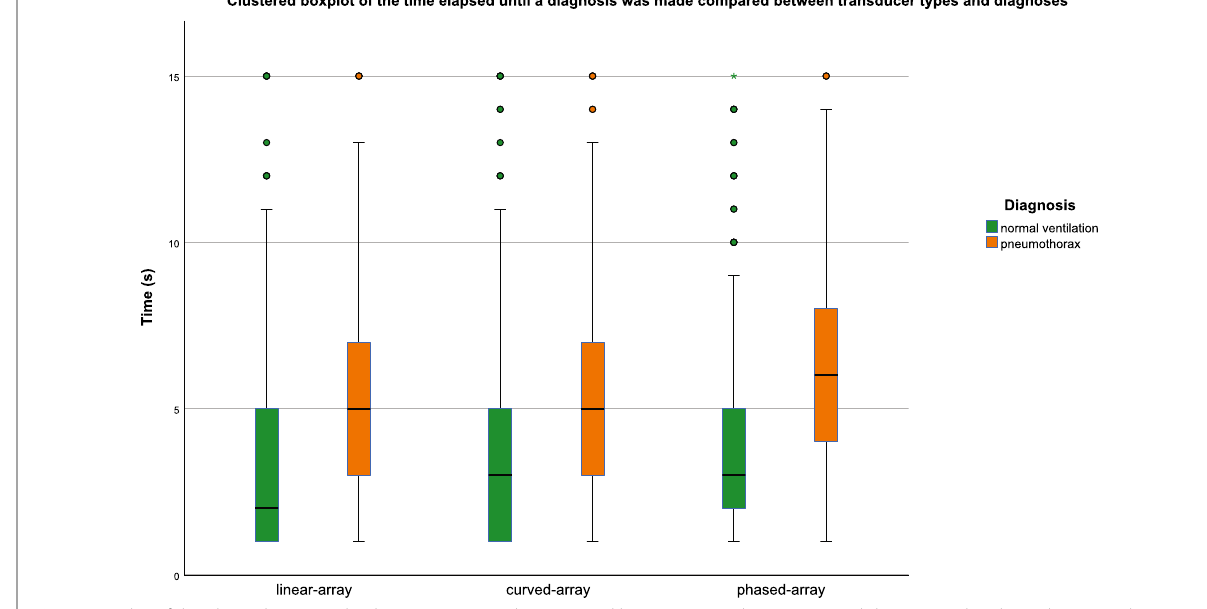
Fig. 5 Boxplot of the elapsed time until a diagnosis was made compared between transducer types and diagnoses. The elapsed time until a diagnosis was stated by the observers. The time is represented in median seconds. The box represents the 25–75% interquartile range. The whiskers indicate the 95% confidence interval. There is a significant difference in the elapsed time until a diagnosis was made between normal ventilation and pneumothorax within all three transducers ( p < .0001)